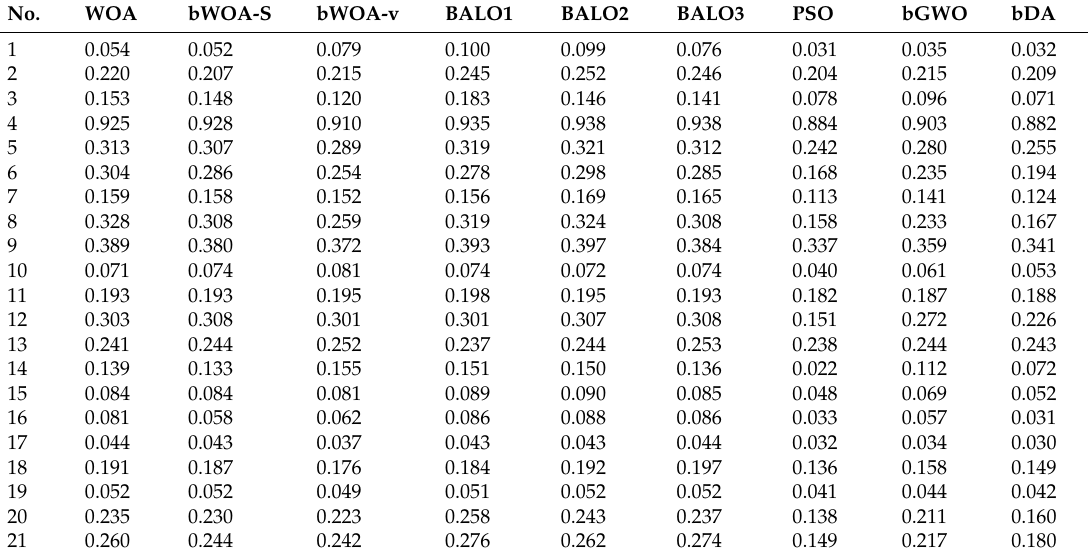
Table 7. Statistical mean fitness measure calculated on the different datasets for the compared algorithms using mixed initialization.